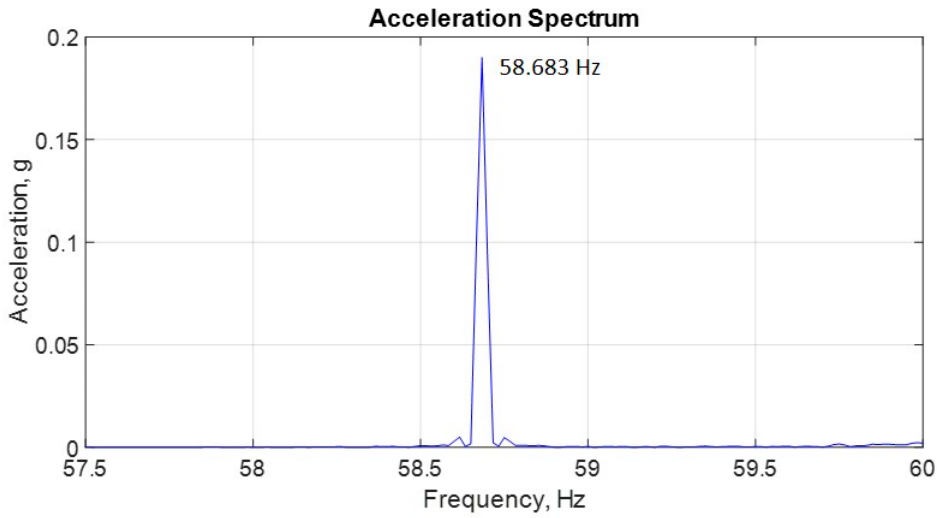
Figure 6. Vibration signal showing the shaft velocity component for the faulty Bearing in 58.683 Hz.